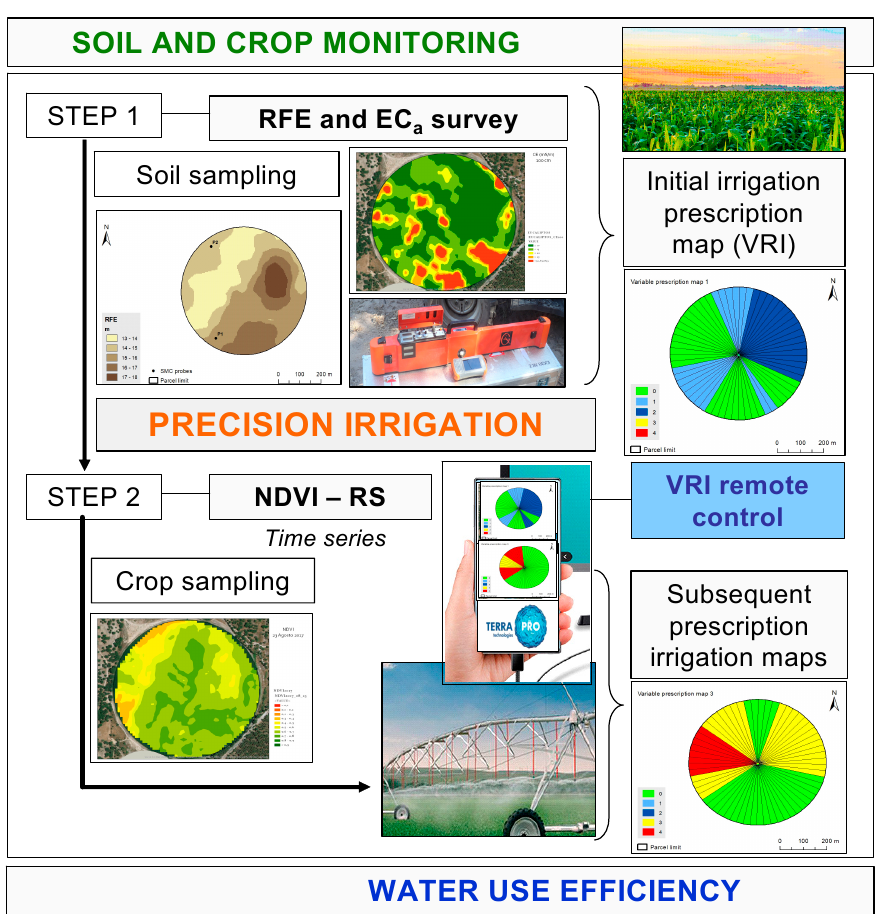
Figure 1. Schematic representation of the methodology followed in this study.